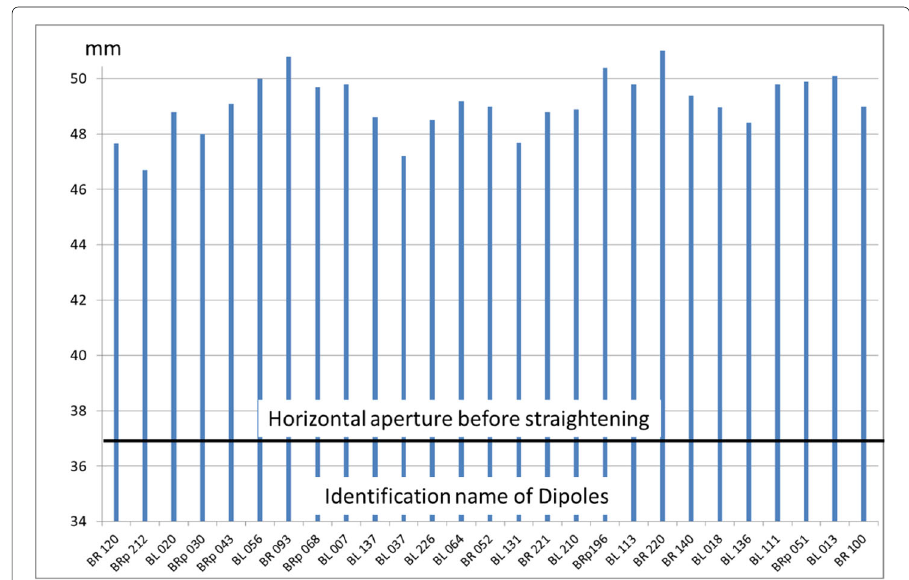
Fig. 20 Achieved horizontal apertures after the straightening of HERA dipoles in mm on the vertical axis versus the identification name of the dipoles according to the chronicle order of the measurements. For comparison the average horizontal aperture before the straightening is shown. For total photon losses below 2 · 10 − 6 an aperture of 45.5 mm is required at the outer ends of the experiment, for infrared light with 1064 nm wavelength used in ALPS